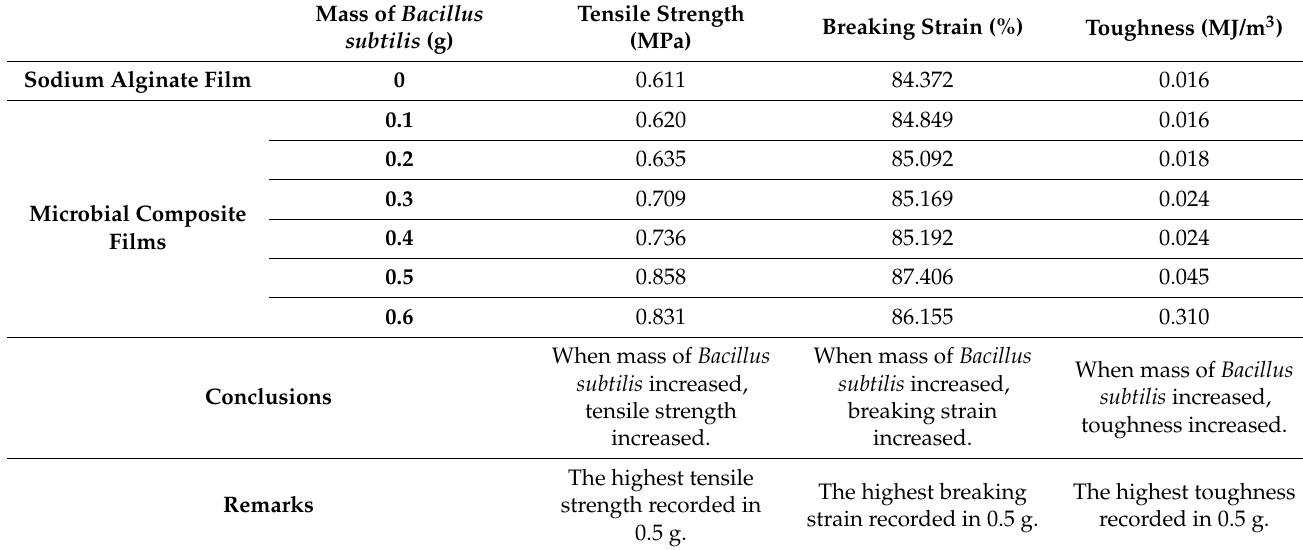
Figure 3. Mechanical properties of microbial composite films with various mass of Bacillus subtilis . ( a ) Tensile strength, ( b ) breaking strain and ( c ) toughness. ( N = 3). Table 1. Tensile strength (MPa), breaking strain (%) and toughness (MJ/m 3 ) of sodium alginate film and microbial composite films.